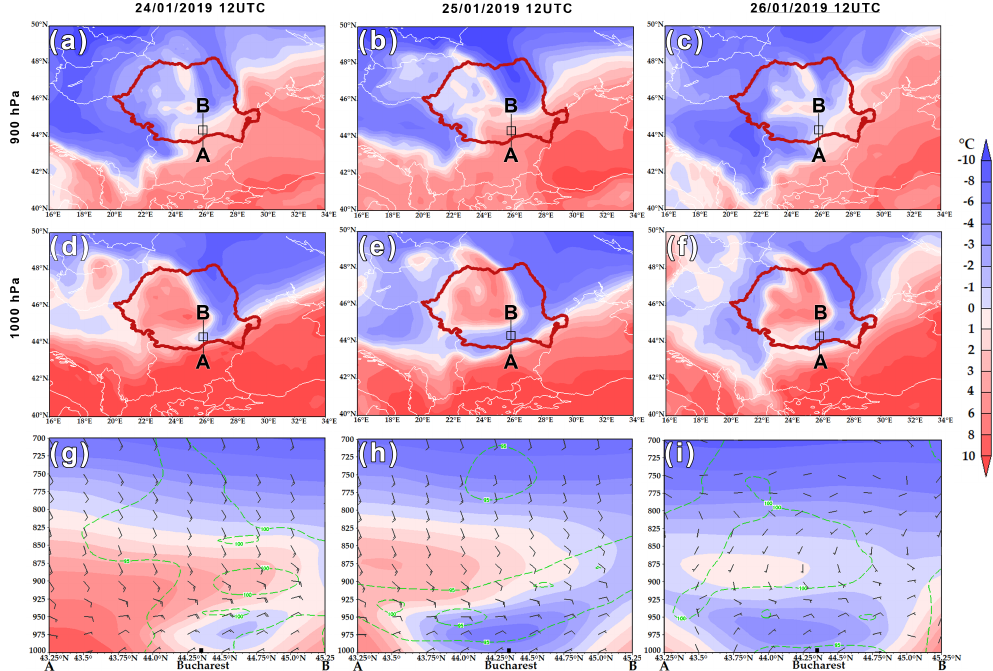
Figure 4. Regional and local analysis of freezing rain event during 24–26 January 2019 at 12 UTC from ERA5. ( a – c ) shows temperature at 900 hPa ( ◦ C, shaded according to the scale every 1 ◦ C between − 4 ◦ C–4 ◦ C and every 2 ◦ C for the remaining contours between − 10 ◦ C–10 ◦ C). ( d – f ) temperature at 1000 hPa (as in a – c ). ( g – i ) the south-north vertical cross section at 26 ◦ E (A–B, Figure 1) showing temperature (as in a–c), relative humidity (green dotted contours, 5% increments) and wind profile (one pennant, full barb, and half-barb denote 25, 5 and 2.5 m s − 1 ,